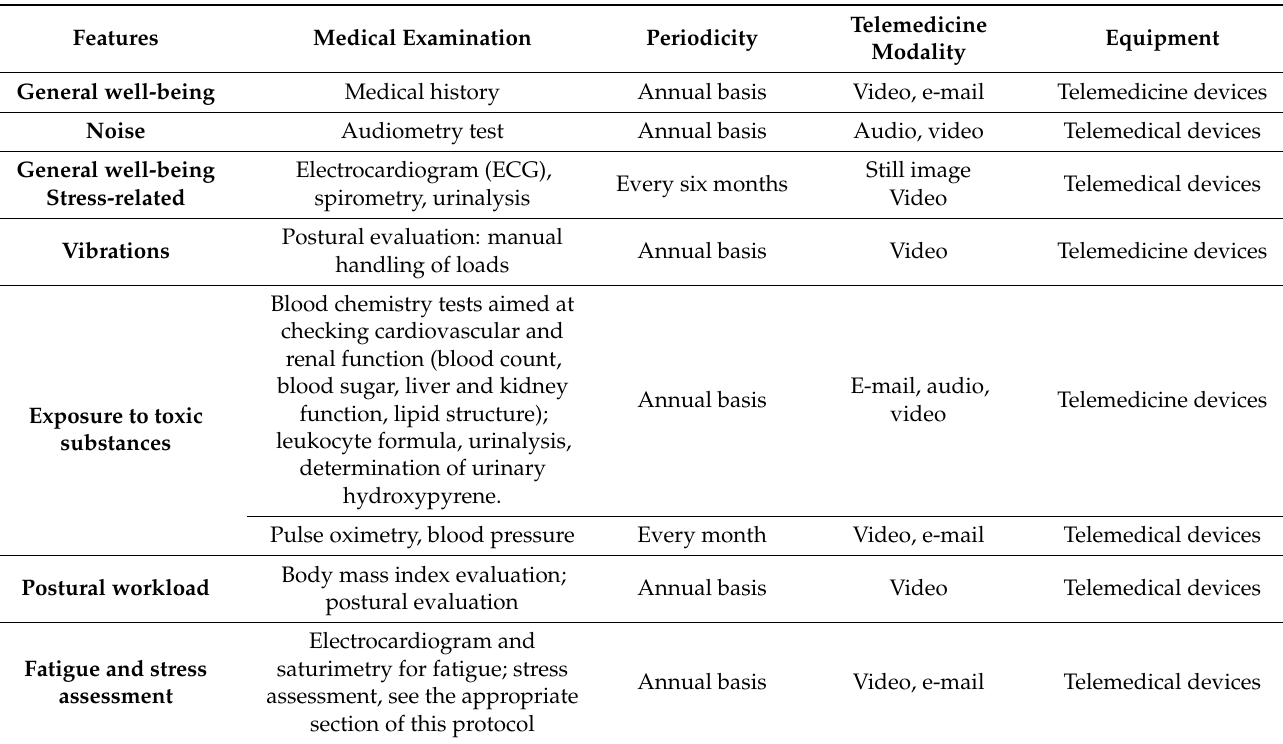
Table 2. The proposed general medical examinations and tests for seafarers on board ships using telemedicine technologies.